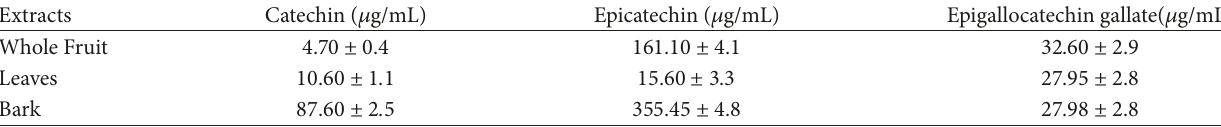
Table 1: Catechin, epicatechin, and epigallocatechin gallate of L. alata .